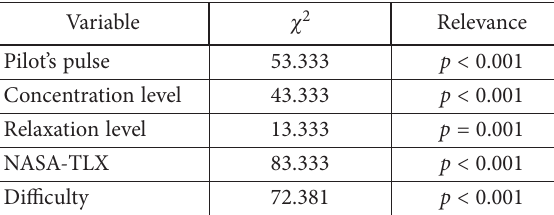
Table 2. Friedman test